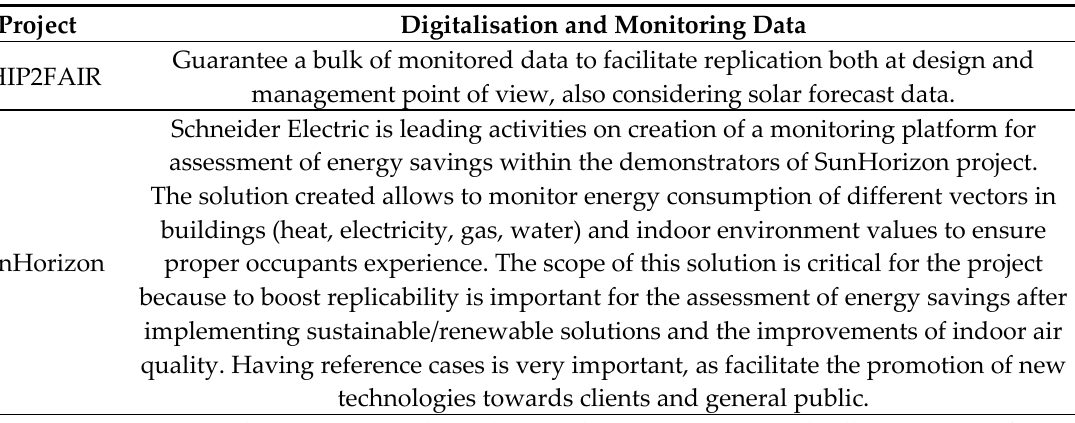
Table 2. Digitalisation and monitoring data.